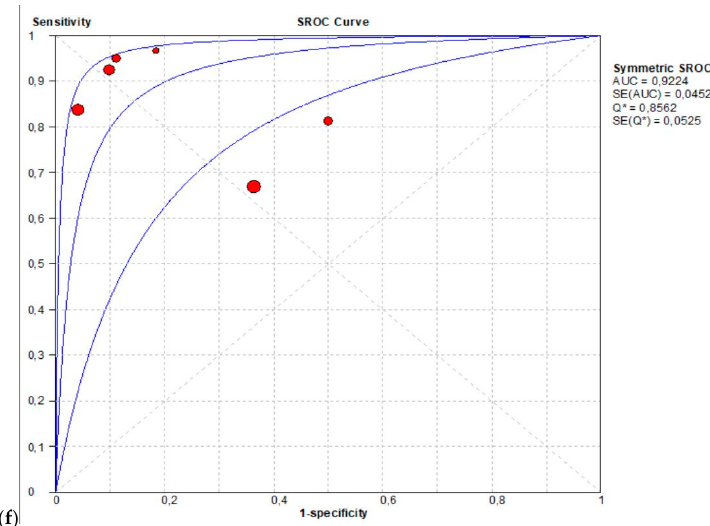
Figure 2. ( a , b ) Forest plot of 18F-Fluciclovine PET/CT for the diagnosis of prostate cancer (sensibility and specificity). ( c , d ) Forest plot of 18F-Fluciclovine PET/CT for the diagnosis of prostate cancer (positive and negative likelihood ratio). ( e , f ): Pooled DOR and SROC curve of 18F-luciclovine PET/CT for the diagnosis of prostate cancer.